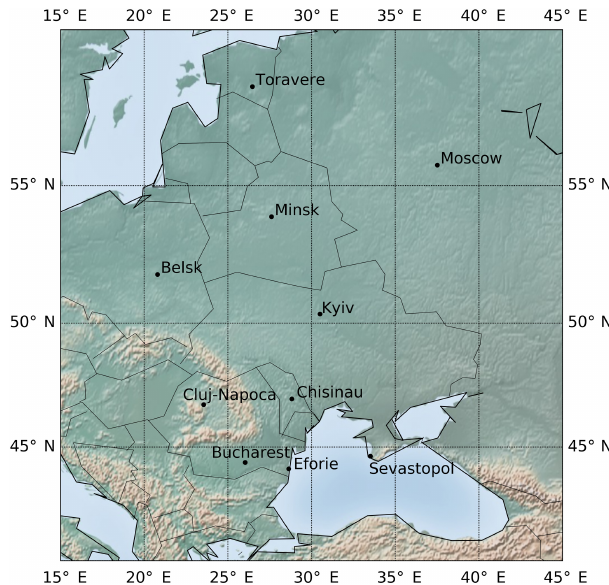
Figure 1. AERONET observational sites in Eastern Europe and Ukraine used in this